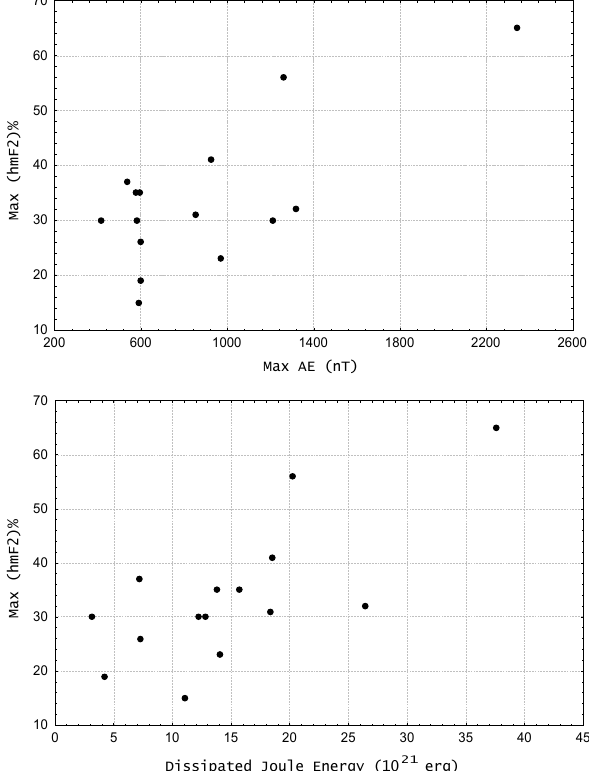
Fig. 11. (a) The maximum d( hm F2)% variation versus the dissi- pated Joule energy in the aurora causing the F2 uplifting event. (b) The maximum d( hm F2)% variation versus the maximum value of AE index for each